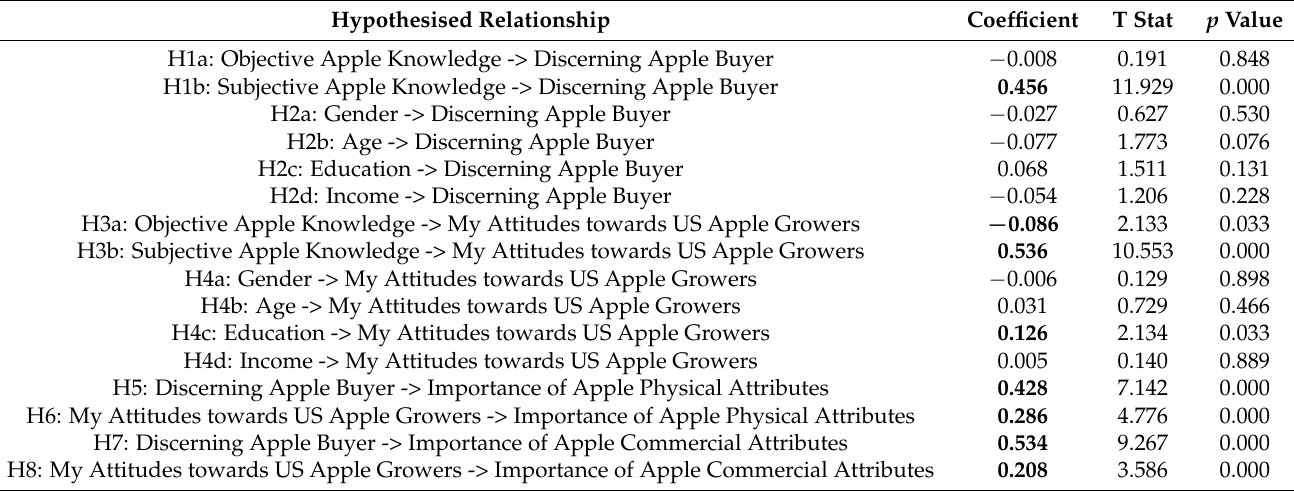
Table 4. Path coefficients and hypothesis testing